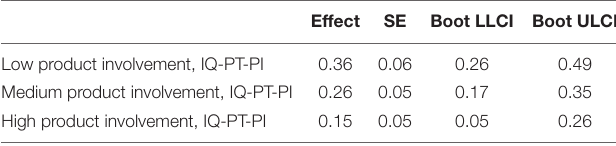
TABLE 7 | Conditional indirect effects of interaction quality on purchase intention via perceived trust at levels of product